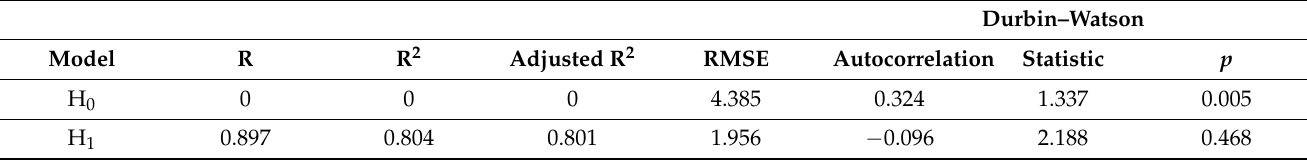
Table 13. Horizontal dry plate method and wet candle method—model.